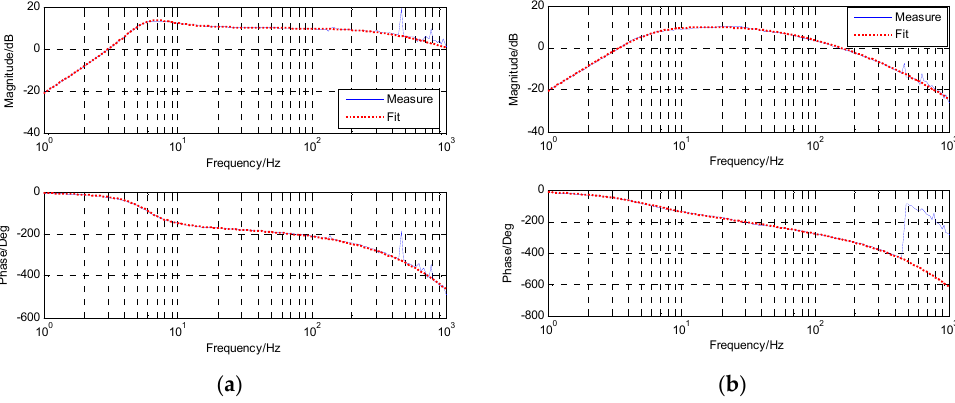
Figure 8. The open-loop bode response of acceleration. ( a ) (cid:101) G a based on the MEMS accelerometer; ( b ) F based on the virtual accelerometer.